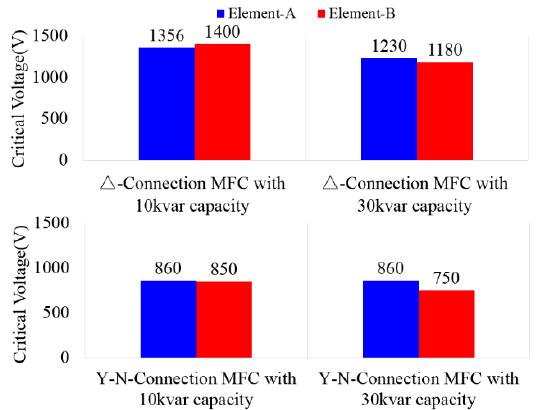
Figure 10. Critical voltages of Δ -connection and Y-N-connection MFCs with different values of reactive power.